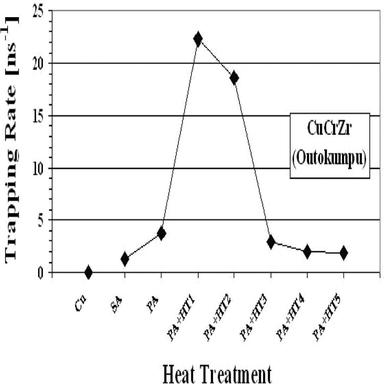
The trapping rate κ in the non-irradiated CuCrZr (Outokumpu) alloy. The trapping rate was derived from the experimental data using Eq.